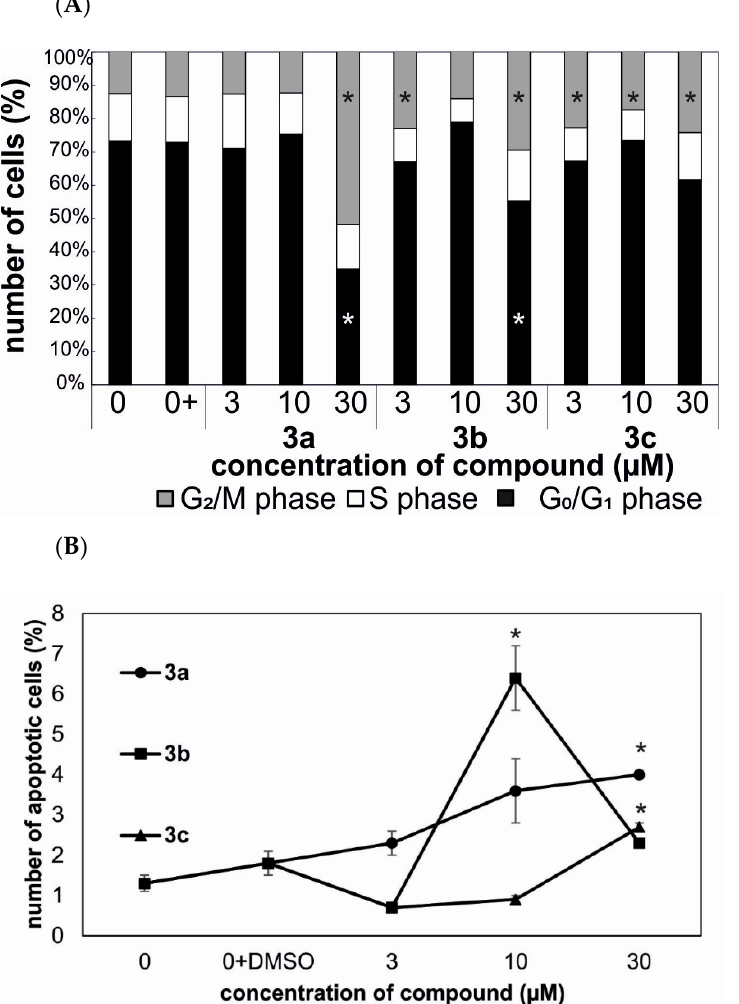
Figure 1. Flow cytometric analysis of cell cycle of HeLa cancer cells ( A ) and apoptosis ( B ). Flow cytometric analysis of cell cycle ( A ) and apoptosis ( B ) of human cervical carcinoma cells (HeLa) after 24 h with 3a – 3c (3, 10 and 30 µM). The bars 0 means control untreated cells, the bars 0+ means control with DMSO. The experiment was repeated at least twice in triplicates. All data were analyzed by statistical software. Significance is indicated with an asterisk (*) ( p ˂ 0.05).